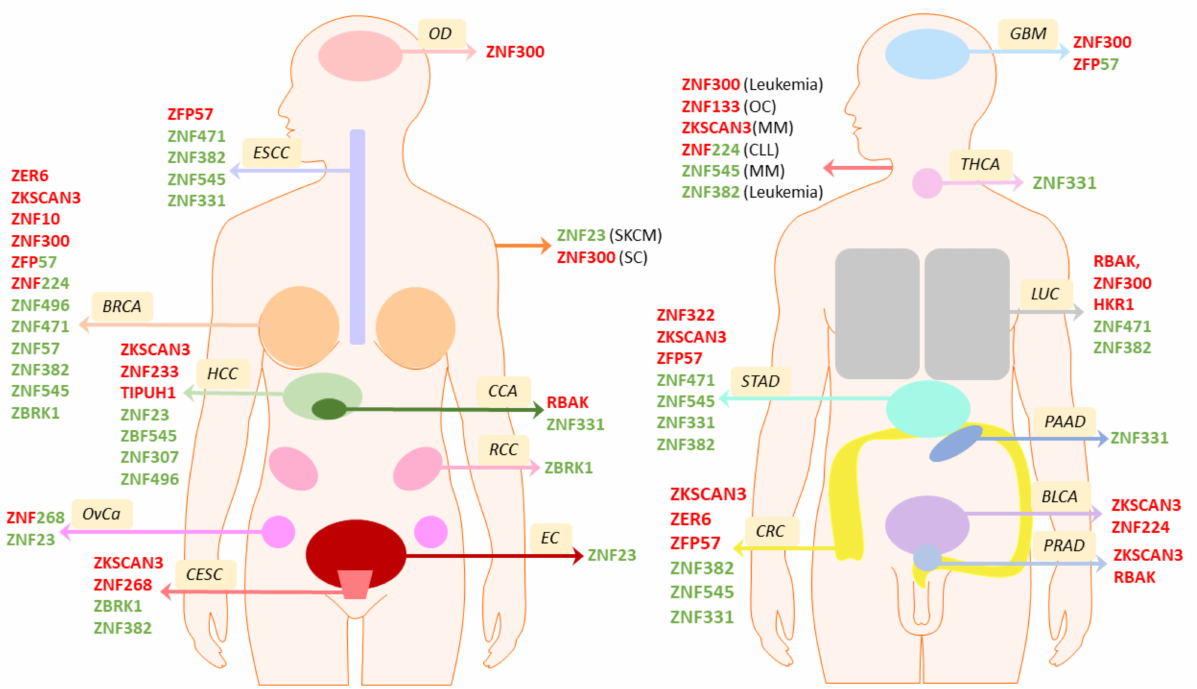
Figure 4. KRAB-ZFPs oncogene and tumor suppressor genes (TSG) role in the cancers of various tissue origins. The scheme presents the localization of different cancers in the human body, in which KRAB-ZFP factors may act as oncogenes (red font, the gene is upregulated) or tumor suppressor genes (green font, the gene is downregulated). Abbreviations: BLCA—bladder cancer, BRCA—breast cancer, CAA—cholangiocarcinoma, CESC—cervical cancer, CLL—chronic lymphocytic leukemia, CRC—colorectal cancer, EC—endometrial cancer, ESCC—esophageal squamous-cell carcinoma, GBM—glioblastoma, HCC— hepatocellular carcinoma, LUC—lung cancer, MM—multiple myeloma, OD—oligodendroglioma; OvCa—ovarian cancer, PAAD—pancreatic cancer, PRAD—prostate adenocarcinoma, RCC—kidney cancer, SC—skin cancer, SKCM—melanoma, STAD—gastric cancer, THCA—thyroid